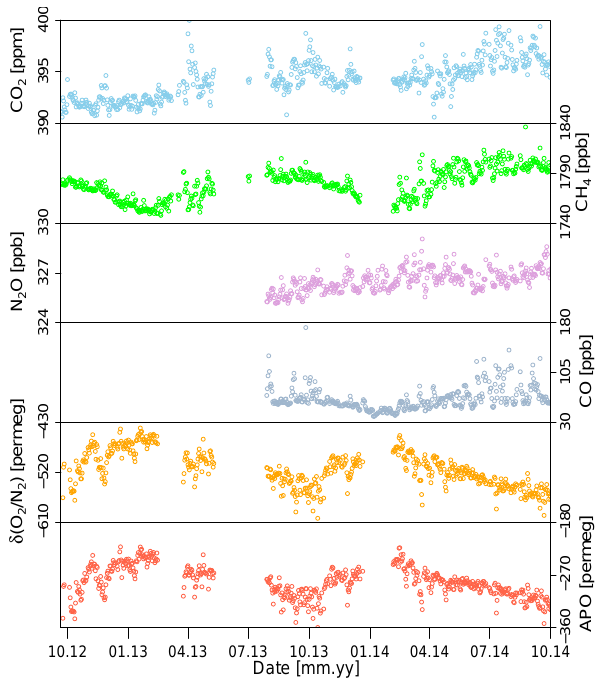
Figure 12. Meteorological time series from NDAO, plotted as daily averages except for solar radiation, which is plotted as a daily max- imum value. 6 ppbyr − 1 (WMO/GAW, 2014). Growth rates of methane vary with location and latitude (Langenfelds et al., 2002; Dlugokencky et al., 1994), so these higher growth rates could be a result of a larger source of CH 4 from the Southern Hemi- sphere for this year. Atmospheric growth rates of N 2 O were only obtained for the two sites with sufficiently overlapping time series at the time of writing, NMB and NDAO. The period considered was July 2013–October 2014. At NMB the growth rate was 0.9 ppbyr − 1 and at NDAO the value was 1.0 ppbyr − 1 . Seasonality is apparent in the meteorological time series, although in the case of air temperature, the diurnal and syn- optic variability masks much of the small seasonal cycle. Wind direction also exhibits some distinct seasonality, with predominately westerly winds (from the ocean) during aus- tral summer and easterly winds during austral winter. All measurands also display the expected seasonality and generally agree well in phasing and amplitude to the other Southern Hemisphere sites. For CO 2 and CO, the seasonal cycle is somewhat distorted, likely due to seasonal changes in atmospheric transport (evident in the seasonality of atmo- spheric pressure, water vapor, and wind direction) at this site which bring continental air masses to the station during aus- tral winter. This variability is also seen in the NMB